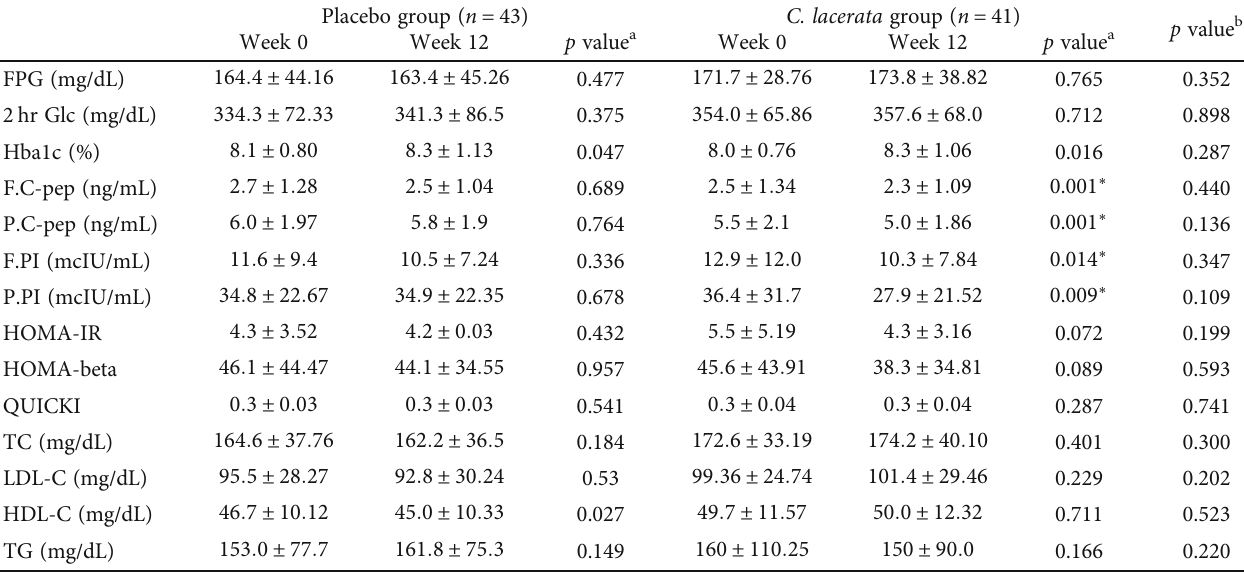
Table 2: Clinical characteristics of the study population. Placebo group ( n = 43 ) C. lacerata group ( n = 41 )